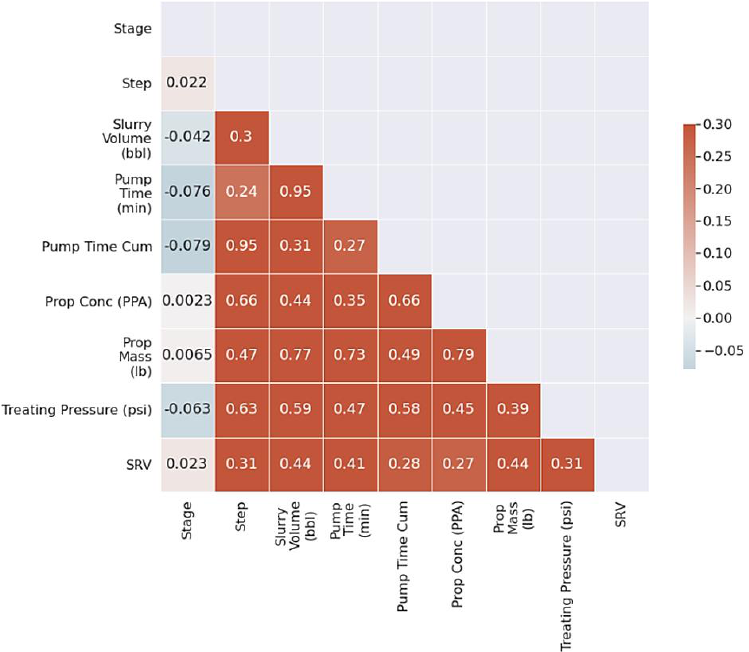
Figure 9. Heat map of the final variables after removing the problematic parameters.